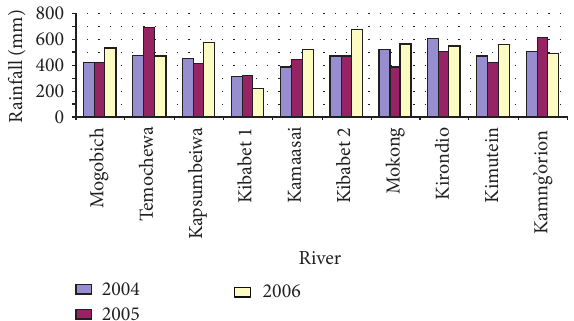
F 2: Four-month total rainfall in 2004, 2005, and 2006. Source